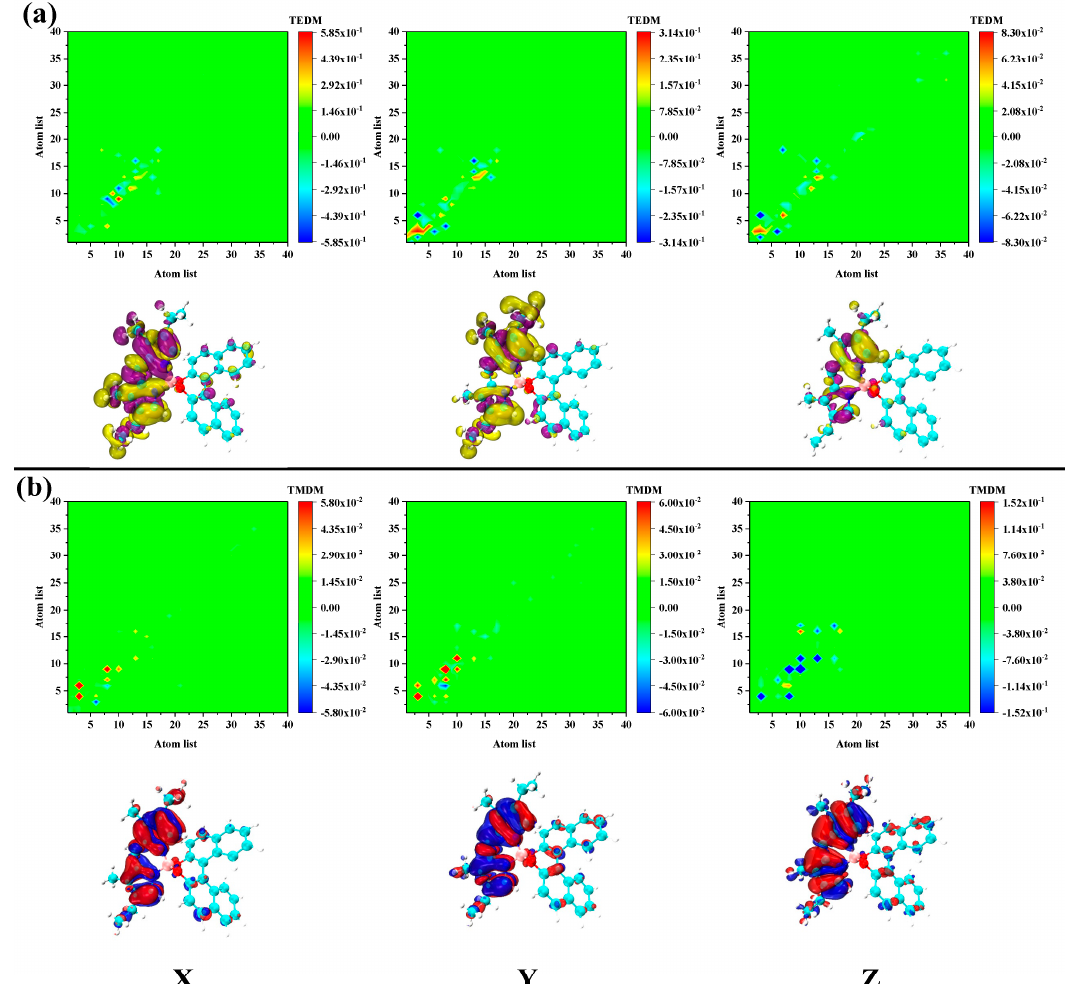
Figure 3. The electron-hole pair density (left) and transition density matrix (TDM) (right) of ( a ) S 1 , ( b ) S 3 , ( c ) S 4 , and ( d ) S 6 . The pink and green isosurfaces signify the electron and hole density, respectively.